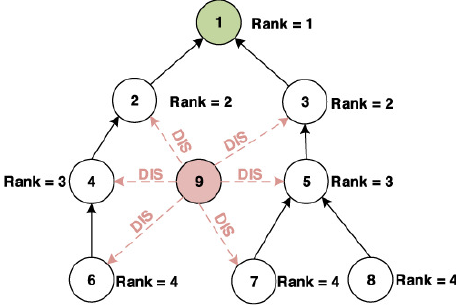
Figure 7. Flooding attack scenario.